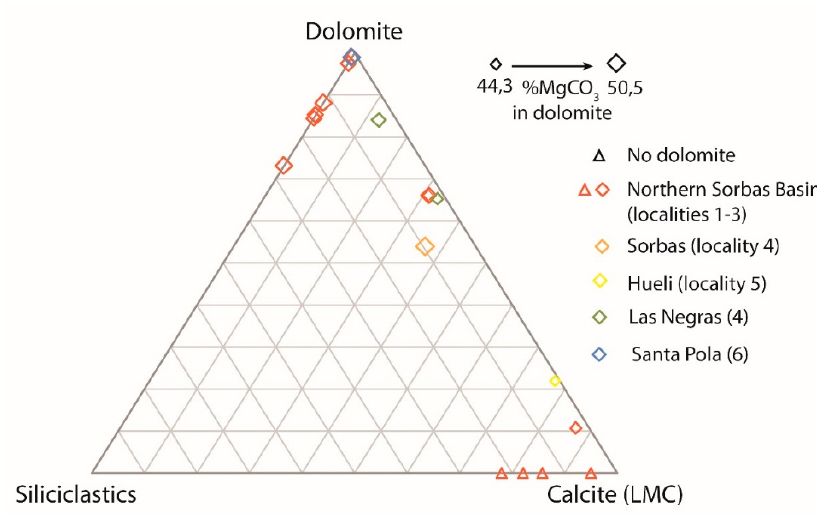
Figure 10. Mineralogical composition of the studied samples represented on a ternary plot dolomite ‐ calcite ‐ siliciclastics. The size of the diamonds is proportional to the %MgCO 3 in the dolomite. The sampled localities are reported in Figure 1A. Details on the mineralogy can be found in Table